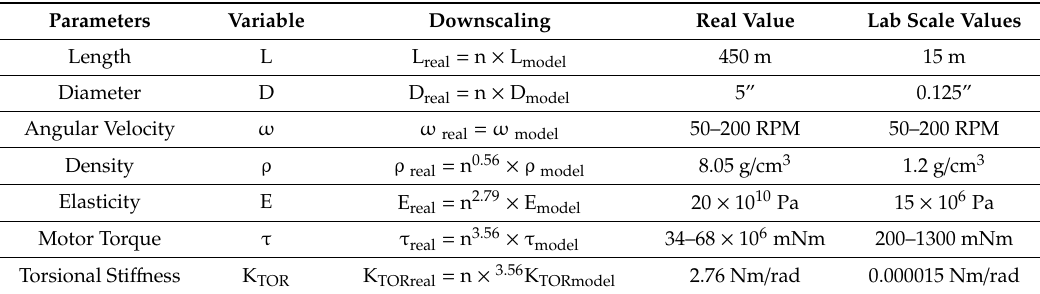
Table 2. Downscaling factors of design